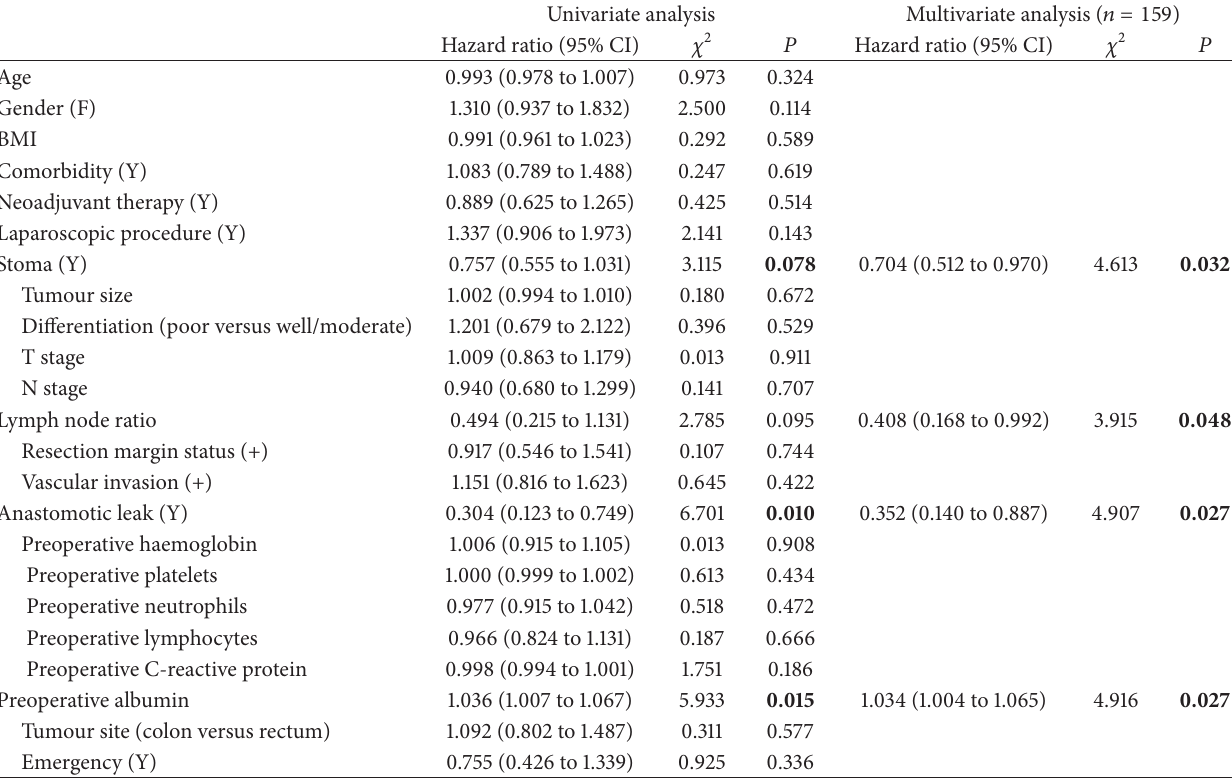
Table 3: Cox regression analysis of factors associated with time from surgery to commencement of adjuvant chemotherapy.